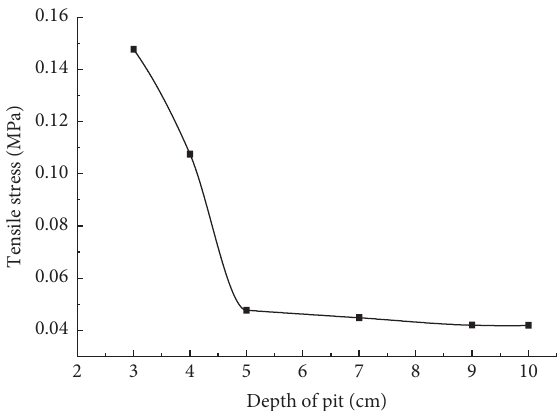
Figure 17: The effect of depth of pit on tensile stress of joint filling materials.